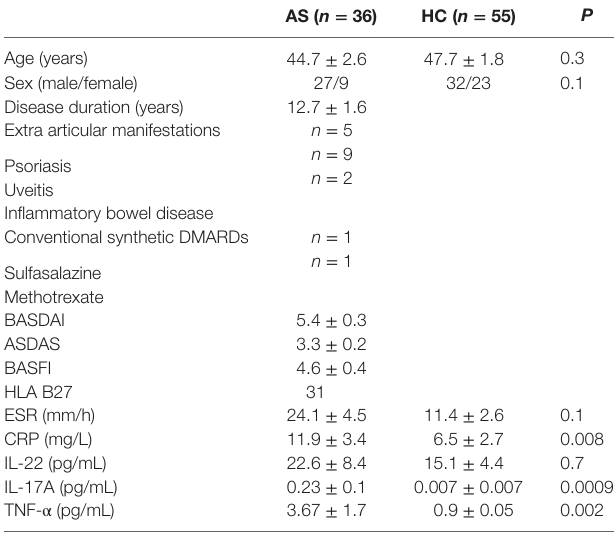
TaBle 1 | Demographic, clinical, and biological characteristics as well as circulating IL-22, IL-17A, and TNF- α levels of patients with AS ( n = 36) and HC ( n =